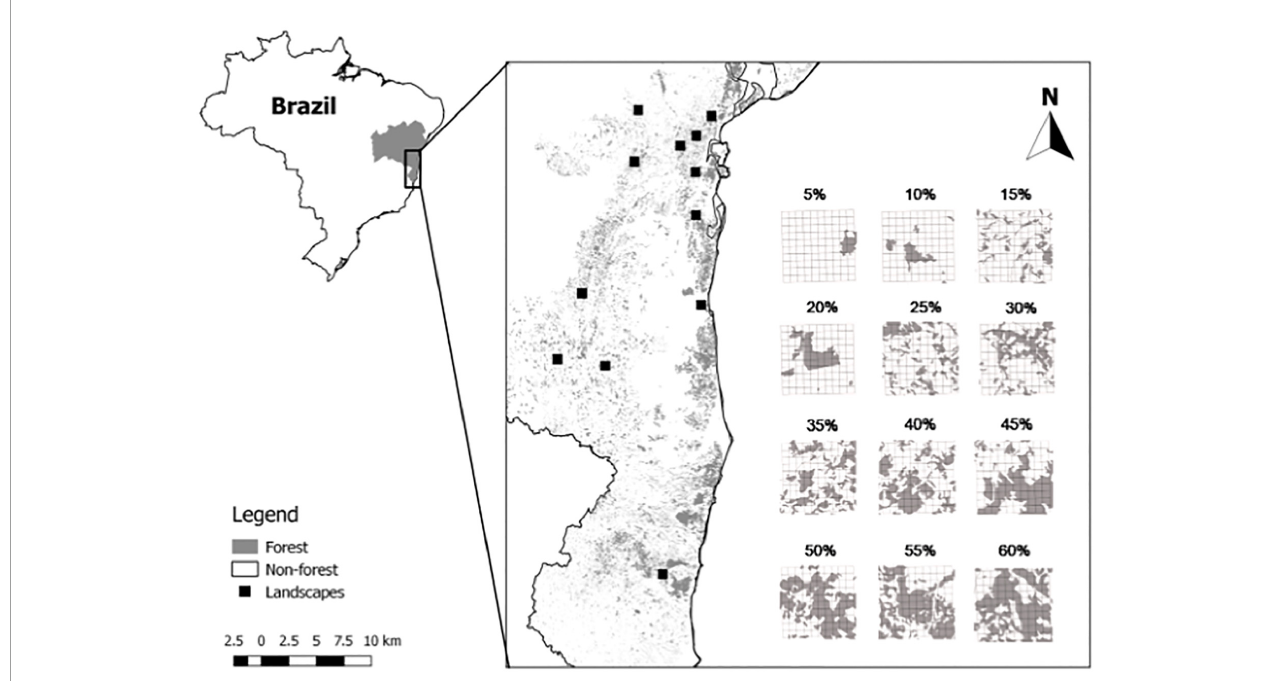
FIGURE1 Map of sampled areas in the state of Bahia, Brazil. 5% (S 14 ◦ 44 (cid:48) 32 (cid:48)(cid:48) W 39 ◦ 06 (cid:48) 20 (cid:48)(cid:48) ), 10% (S 15 ◦ 10 (cid:48) 58 (cid:48)(cid:48) W 40 ◦ 20 (cid:48) 28 (cid:48)(cid:48) ), 15% (S 13 ◦ 23 (cid:48) 28 (cid:48)(cid:48) W 39 ◦ 19 (cid:48) 06 (cid:48)(cid:48) ), 20% (S 15 ◦ 14 (cid:48) 46 (cid:48)(cid:48) W 38 ◦ 56 (cid:48) 25 (cid:48)(cid:48) ), 25% (S 13 ◦ 20 (cid:48) 32 (cid:48)(cid:48) W 39 ◦ 11 (cid:48) 43 (cid:48)(cid:48) ), 30% (13 ◦ 07 (cid:48) 19 (cid:48)(cid:48) W 39 ◦ 39 (cid:48) 34 (cid:48)(cid:48) ), 35% (13 ◦ 38 (cid:48) 58 (cid:48)(cid:48) W 39 ◦ 12 (cid:48) 37 (cid:48)(cid:48) ), 40% (13 ◦ 33 (cid:48) 14 (cid:48)(cid:48) W 39 ◦ 42 (cid:48) 07 (cid:48)(cid:48) ), 45% (14 ◦ 00 (cid:48) 51 (cid:48)(cid:48) W 39 ◦ 10 (cid:48) 56 (cid:48)(cid:48) ), 50% (14 ◦ 38 (cid:48) 38 (cid:48)(cid:48) W 40 ◦ 09 (cid:48) 12 (cid:48)(cid:48) ), 55% (13 ◦ 11 (cid:48) 14 (cid:48)(cid:48) W 39 ◦ 01 (cid:48) 26 (cid:48)(cid:48) ), 60% (16 ◦ 59 (cid:48) 30 (cid:48)(cid:48) W 39 ◦ 27 (cid:48) 19 (cid:48)(cid:48)